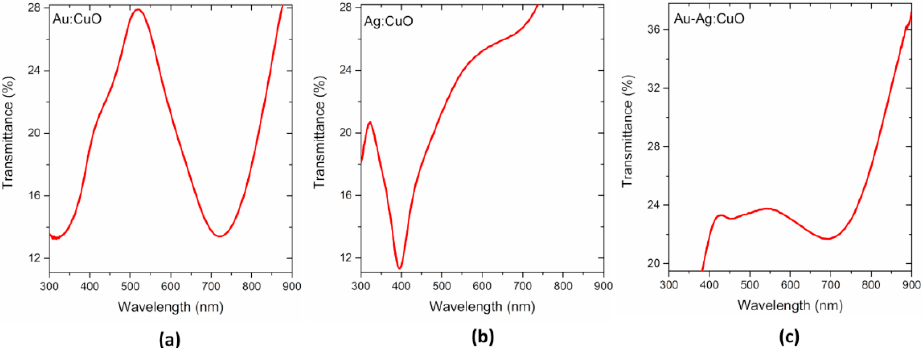
Figure 7. Transmittance spectra of the Au:CuO ( a ), Ag:CuO ( b ), and Au-Ag:CuO ( c ) thin films after in-air annealing.